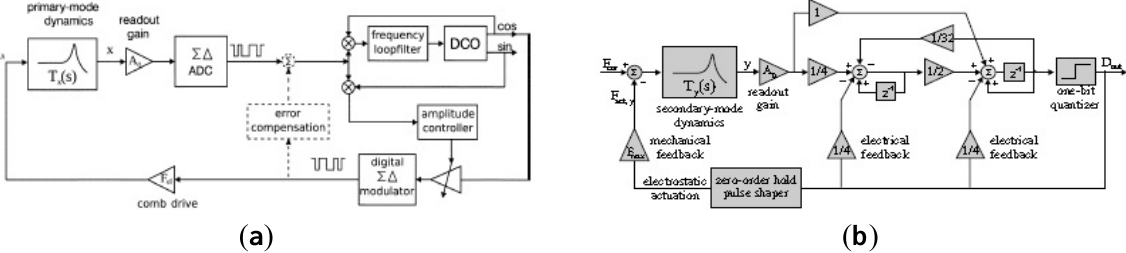
Figure 34. Ghent University of Belgium ΣΔ circuits. ( a ) drive mode. ( b ) detection